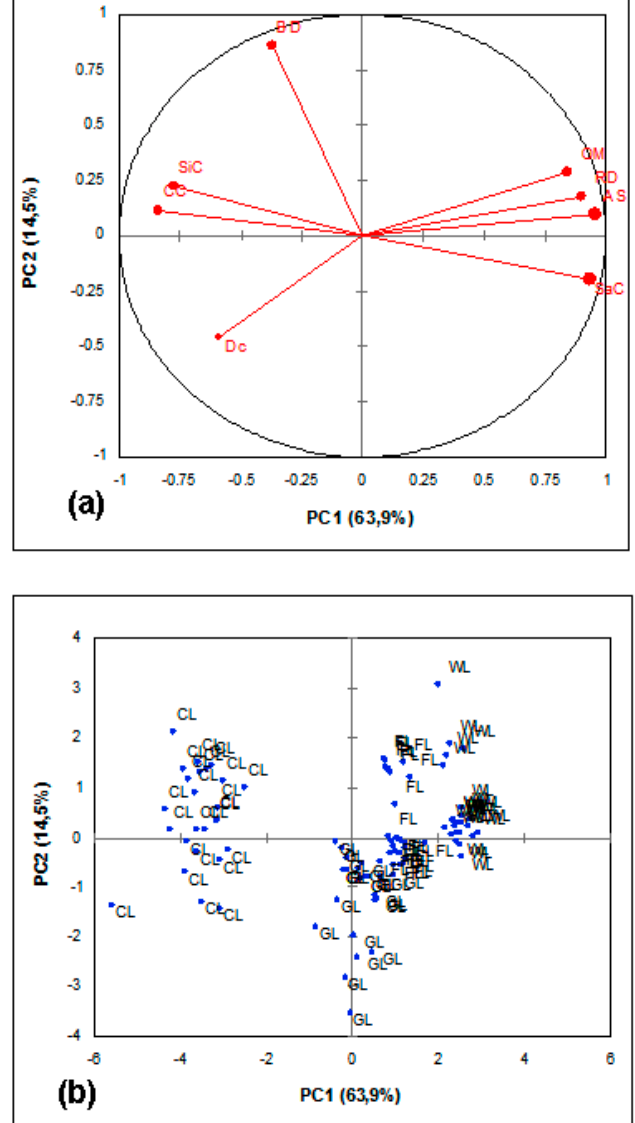
Figure 4. Loadings of soil and hydraulic parameters ( a ), and scores of soil samples ( b ) on the first two principal components (PC) (the percentage variation explained by the principal components is given in parentheses) for four land uses in the Saravan watershed (Northern Iran). Legend: D c = rill detachment capacity; OM = organic matter content; BD = bulk density; RD = root weight density; AS = aggregate stability in water; SaC = sand content; SiC = silt content; CC = clay content; CL = cropland; GL = grassland; WL = woodland; FL = forestland.